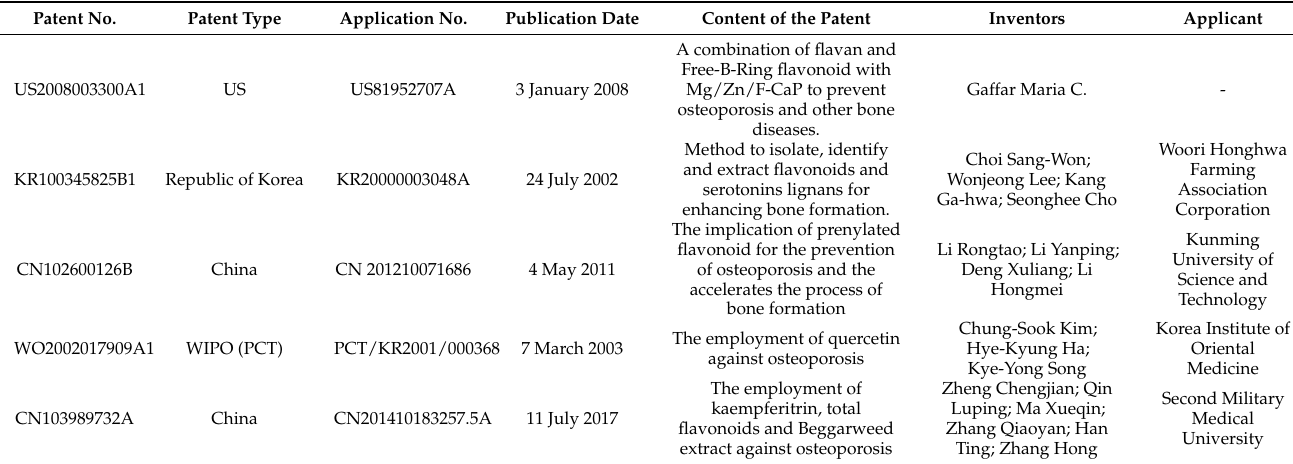
Table 5. Patents of flavonoids for treating bone